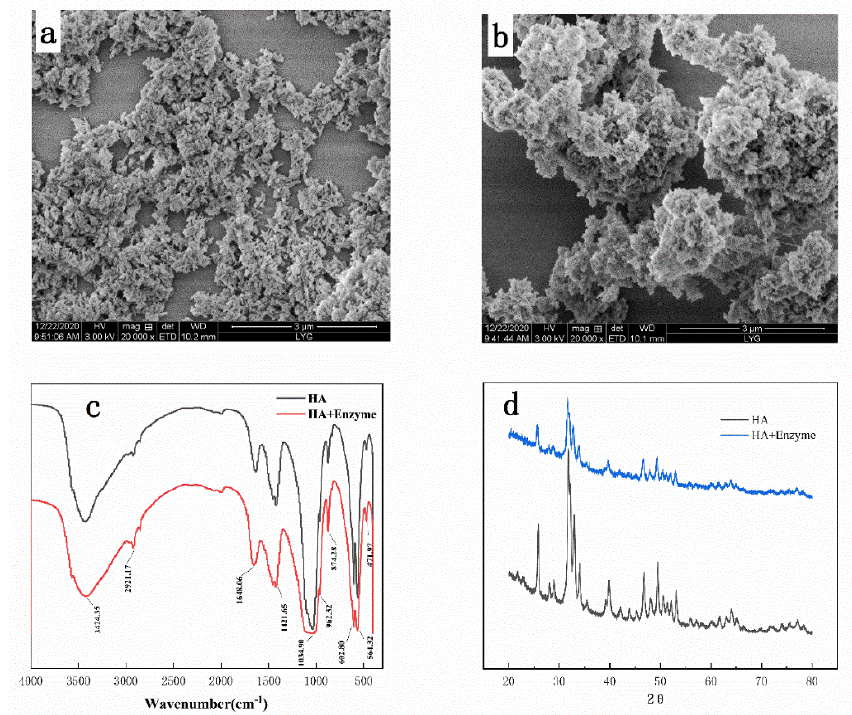
Figure 4. Detection of HA and immobilized dextranase; ( a ) field emission gun-scanning electron microscope (FEG-SEM) images of HA, ( b ) FEG-SEM images of immobilized dextranase, ( c ) FT-IR spectra, and ( d ) XRD spectra.